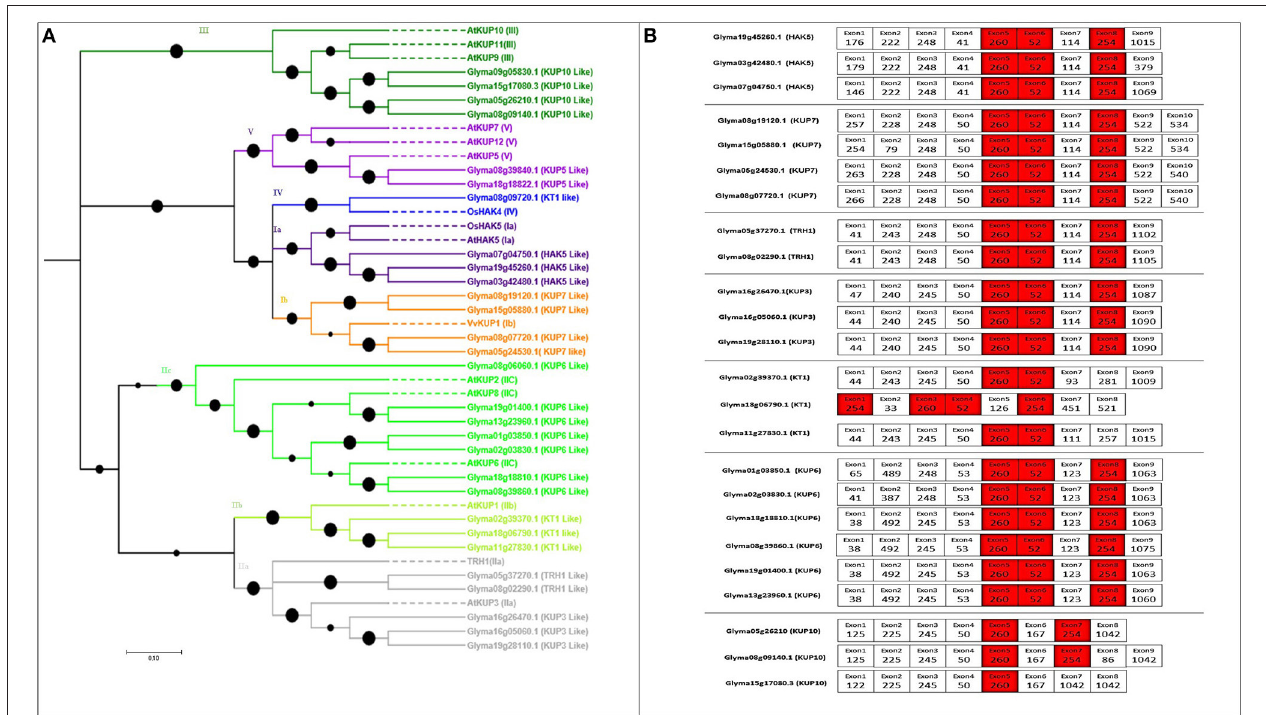
FIGURE 1 | Phylogenetic tree of putative HAK/KT/KUP transporters in soybean with their exon structure and splice sites. (A) Five clearly distinguished clades of HAK transporters are present in soybean. Each represents an independent group of paralogs. To construct the phylogenetic tree, reference genes were taken from Arabidopsis , rice, and grapes (indicated as dotted lines). Soybean genes were shown by bold lines (B) Exon structure (5 ′ –3 ′ ) and splice-site analysis of each tandemly or segmentally duplicated soybean HAK/KT/KUP pair. Nucleotide lengths are given as numbers in boxes. Exons colored red are conserved in length among all soybean HAK/KT/KUP genes. Exons colored white are conserved in length between each duplicated pair. Black colored filled circles on the phylogenic tree are showing branch lengths.